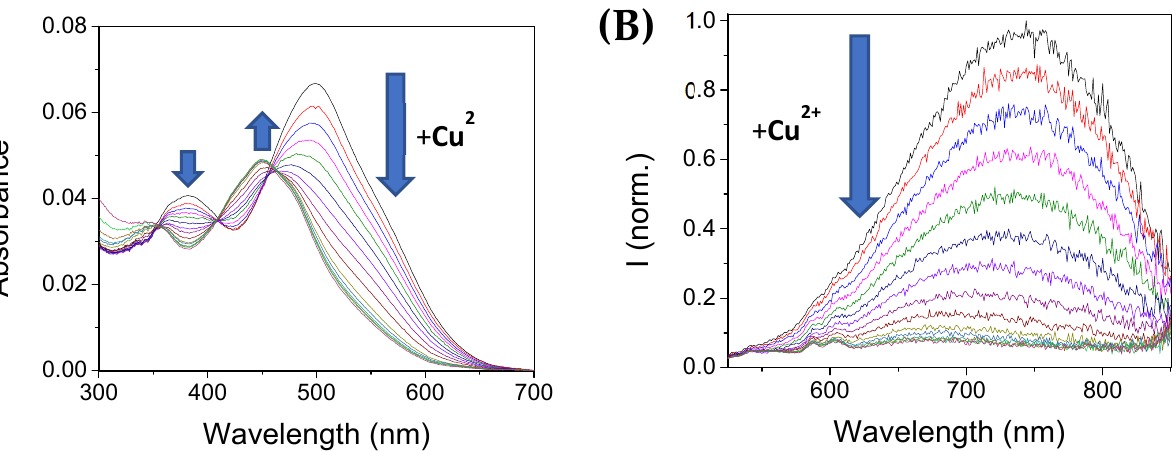
Figure 4. UV-Vis ( A ) and emission ( B ) spectra of 4 (2.5 μ M) upon addition of increasing amounts of Cu 2+ , in a 50:50 mixture of methanol and 0.01 M HEPES buffer at pH = 7.1 ( λ EXC = 500 nm). For the UV-Vis absorption spectra, a decrease in the absorption bands centered at 382 and 500 nm was observed upon increasing Cu 2+ concentration, along with a simultaneous rise in a new band at circa 450 nm, corresponding to 4 -Cu 2+ complex. The emission from 4 was also strongly quenched by increasing amounts of Cu 2+ up to about 1 equivalent, from which point it reached a plateau and remained unchanged (Figures 4B and 6A, below).